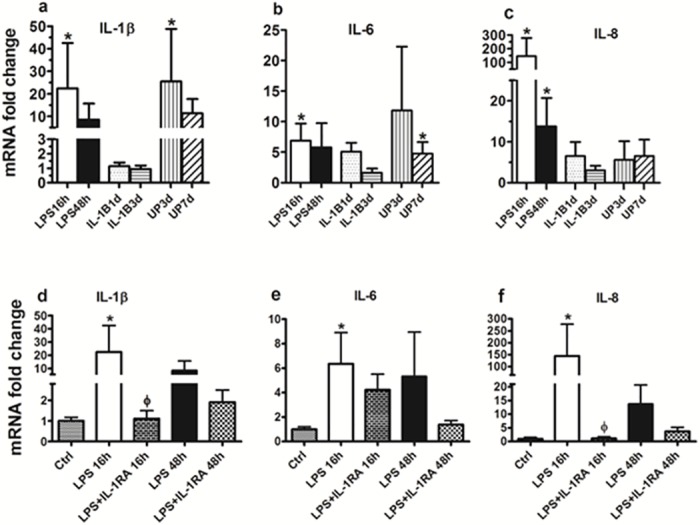
Cytokine PCR Analysis.Quantitative PCR analysis of cytokines in fetal rhesus macaque skin following intra-amniotic exposure with LPS, IL-1β or UP and for different times of exposure (Panel a, b and c). Cytokine expression for LPS and LPS plus IL-1ra exposure groups (Panel d, e and f). Graphs represent mean mRNA fold change ± SD. *indicates a significant increase in transcript expression relative to untreated control group normalized to a value for 1.0. ɸ indicates a significant decrease in transcript expression relative to LPS at 16 hours.